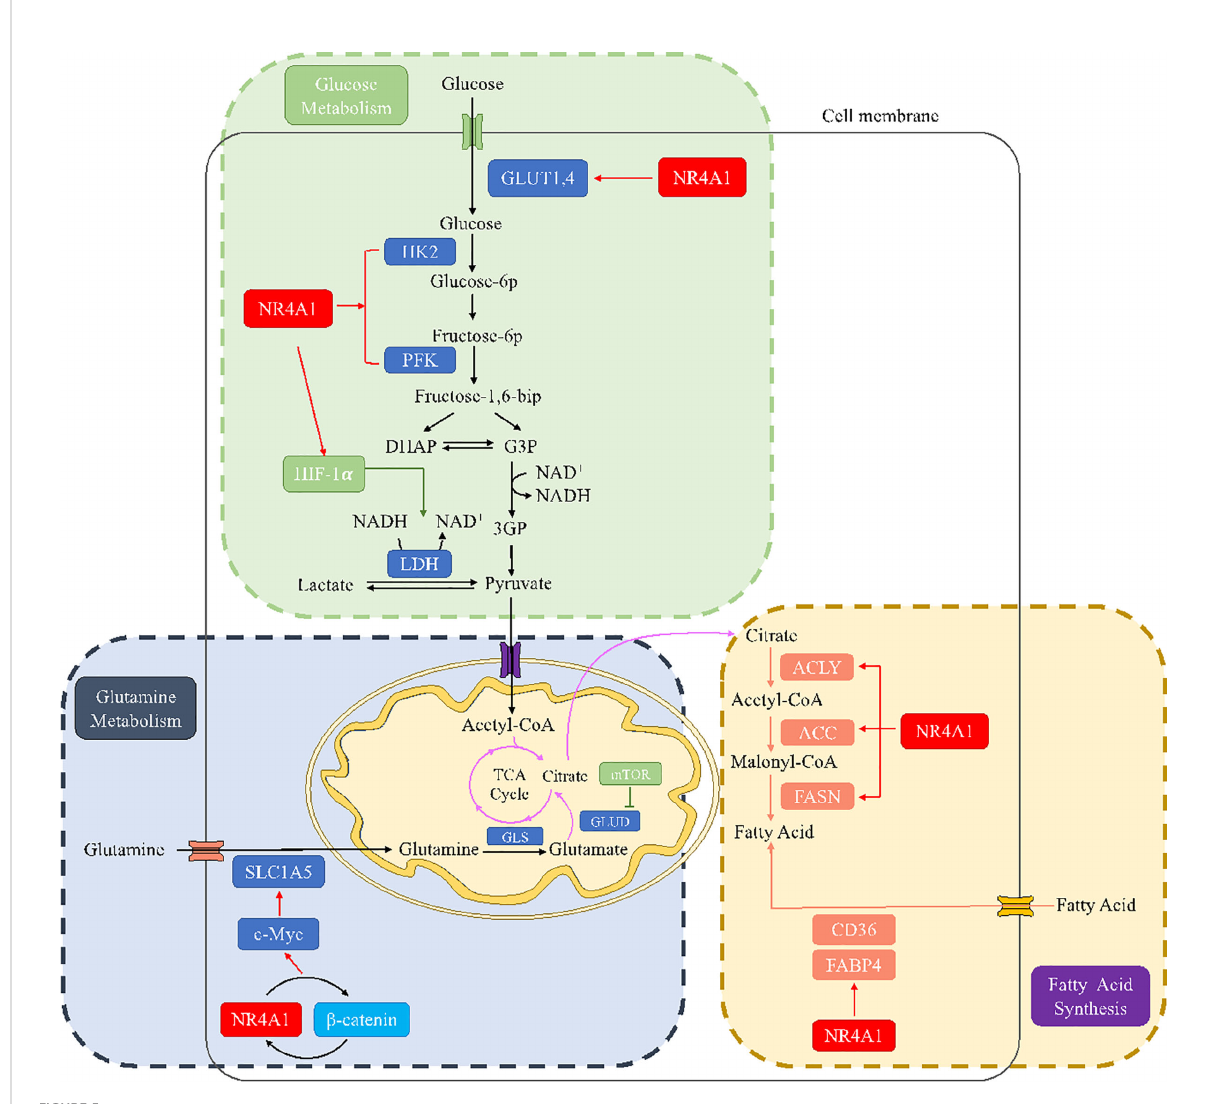
FIGURE 5 The metabolic regulation of NR4A1 in glucose, glutamine, and fatty acid metabolism. In glucose metabolism, NR4A1 can regulate glucose transporter GLUT1 and 4, key enzymes HK and PFK, as well as HIF-1 a . NR4A1 mediates glutamine metabolism by regulating SLC1A5 via c-Myc. NR4A1 can regulate the fatty acid synthesis of major enzymes ACLY, ACC, and FASN, and it also participates in fatty acid uptake through CD36 and